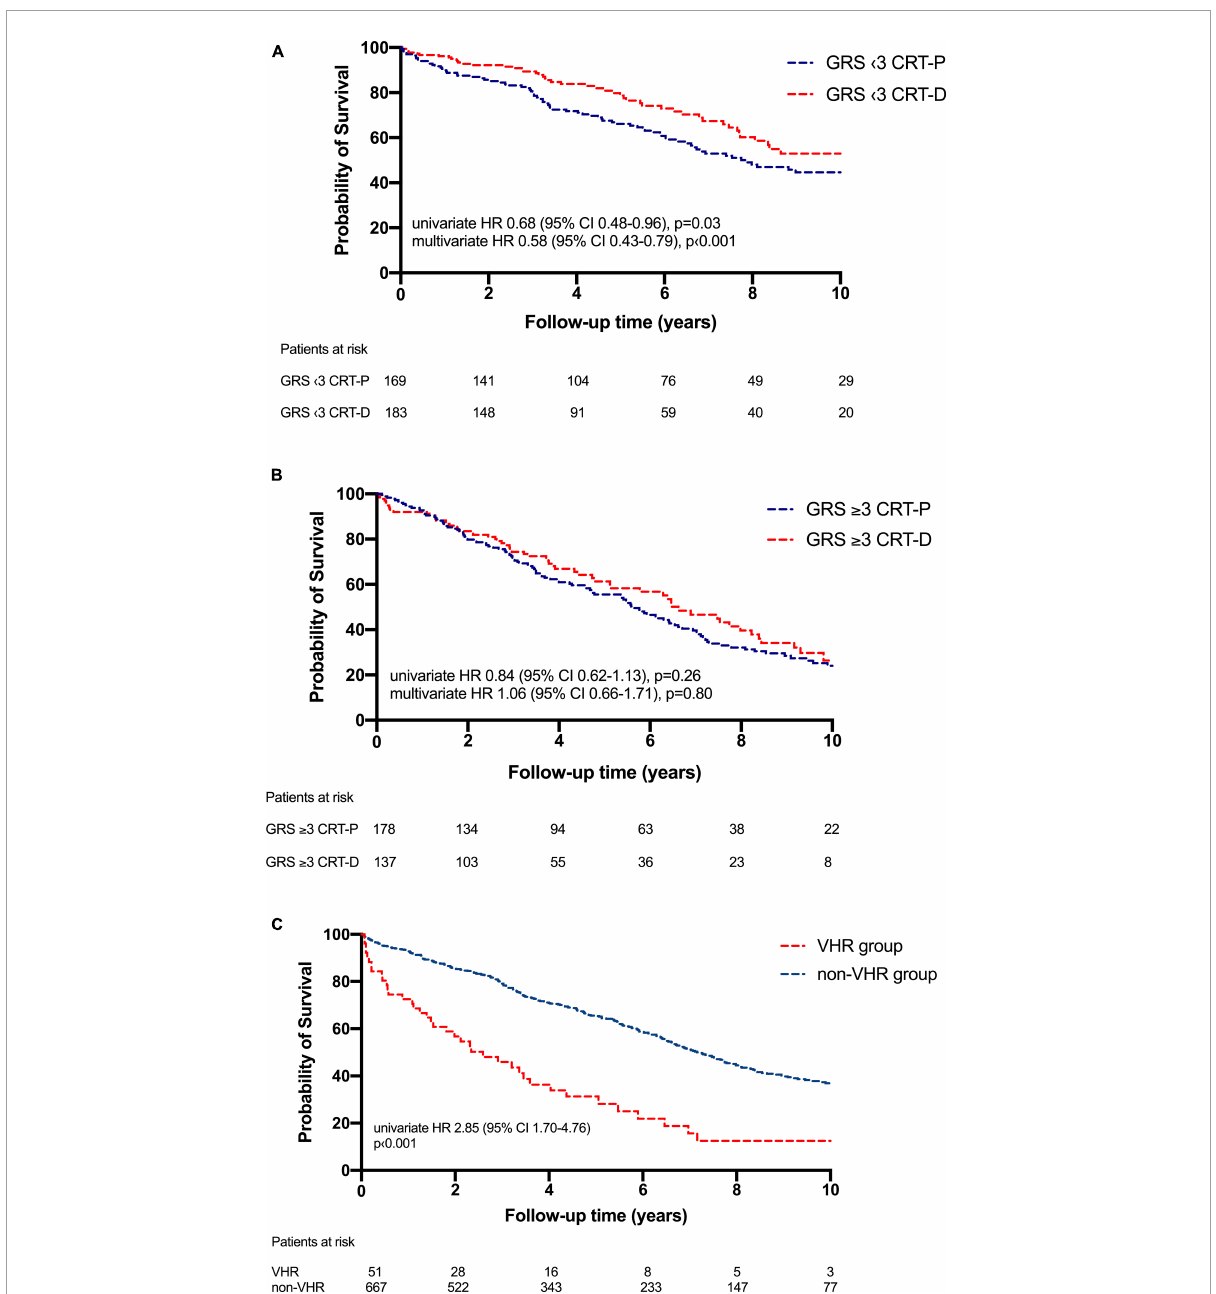
FIGURE3 (A) Kaplan–Meier estimates of survival comparing cardiac resynchronization therapy-defibrillator (CRT-D) and cardiac resynchronization therapy-pacemaker (CRT-P) therapies in low-risk patients ( < 3). In low-risk groups CRT-D was associated with mortality benefit at long-term (HR 0.68; 95% CI 0.48–0.96; p = 0.03) compared to CRT-P. (B) Kaplan–Meier estimates of survival comparing CRT-D and CRT-P therapies in high-risk patients [Goldenberg risk score (GRS) ≥ 3]. In this patient group CRT-D did not provide a mortality benefit (HR 0.84; 95% CI 0.62–1.13; p = 0.26) compared to CRT-P at long-term. (C) Kaplan–Meier estimates of survival in very-high-risk patients (VHR group) compared to the study population (non-VHR group). An almost threefold higher risk of all-cause mortality could be observed in the VHR patient group (HR 2.85; 95% CI 1.70–4.76; p < 0.001) compared to the non-VHR group.